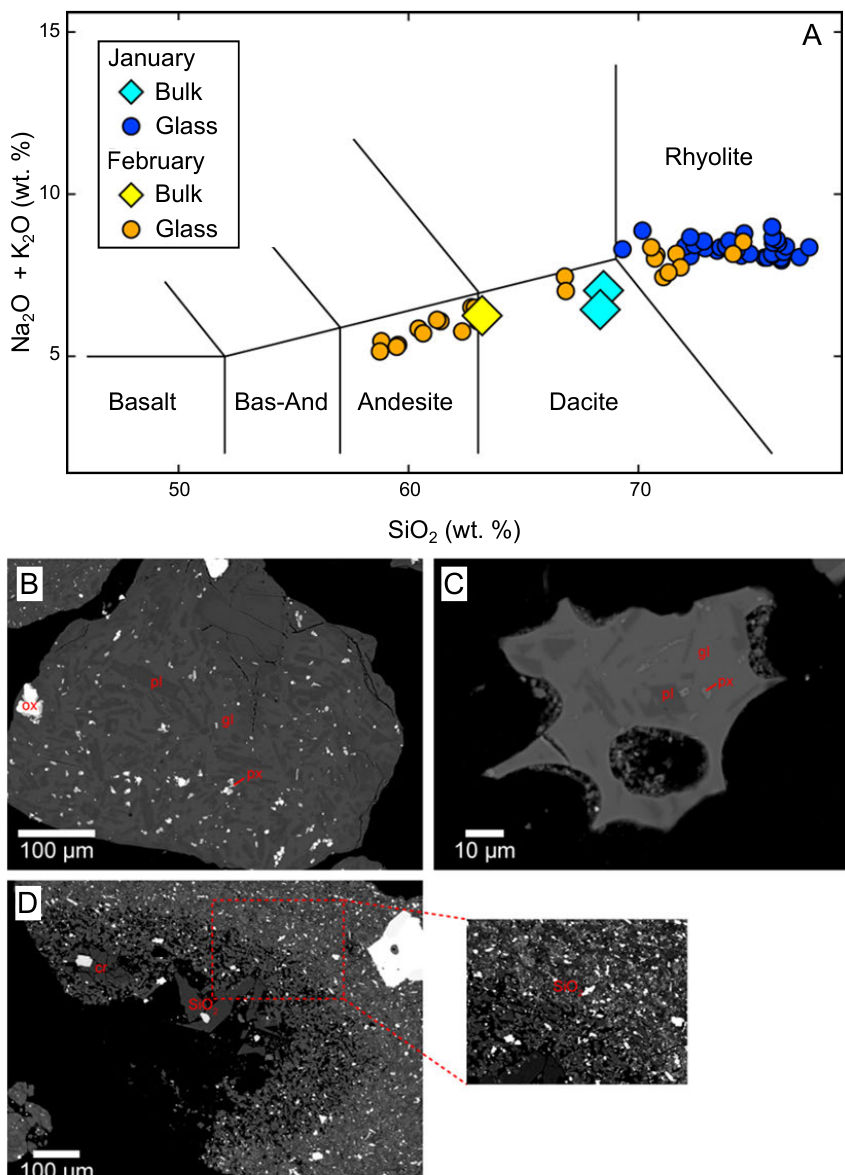
Figure 6: Textures and geochemistry of tephra. [A] Total alkali-silica diagram showing the compositions of bulk tephra samples (Table 3) and interstitial glass within grains. [B]–[C] BSE images of tephra fragments showing the dacitic material that dominated the 8 January blast material and 11 October material [B], and the andesitic component that is also present in the February blast material [C]. Components are marked glass (gl), plagioclase (pl), pyroxene (px), and oxides (ox). [D] BSE image of SiO polymorph-bearing dacite from 8 January. Note that 2 fishscale cracking that is diagnostic of cristobalite. Expanded view with high-contrast colour balance